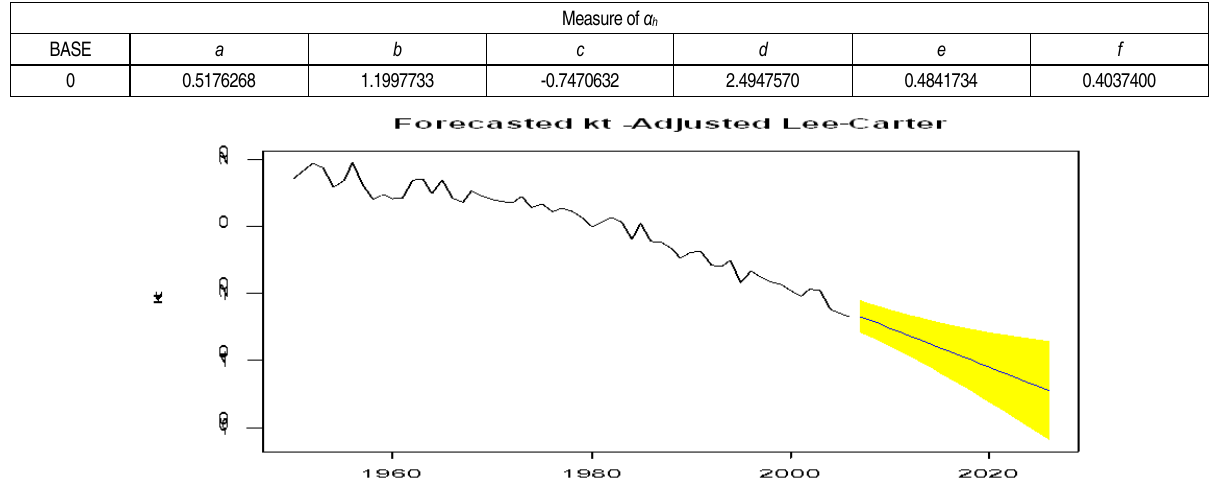
, ASLC model h Measure of α h